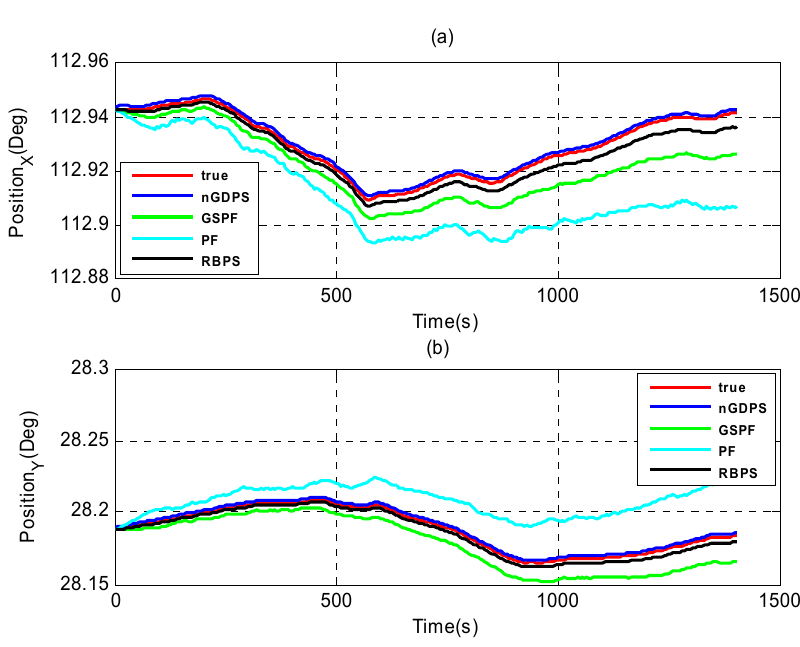
Figure 6. Estimate position results of nGDPS, GSPF and RBPS versus true vehicle state in (X, Y)-coordinates. ( a ) X-coordinates; ( b ) Y-coordinates.